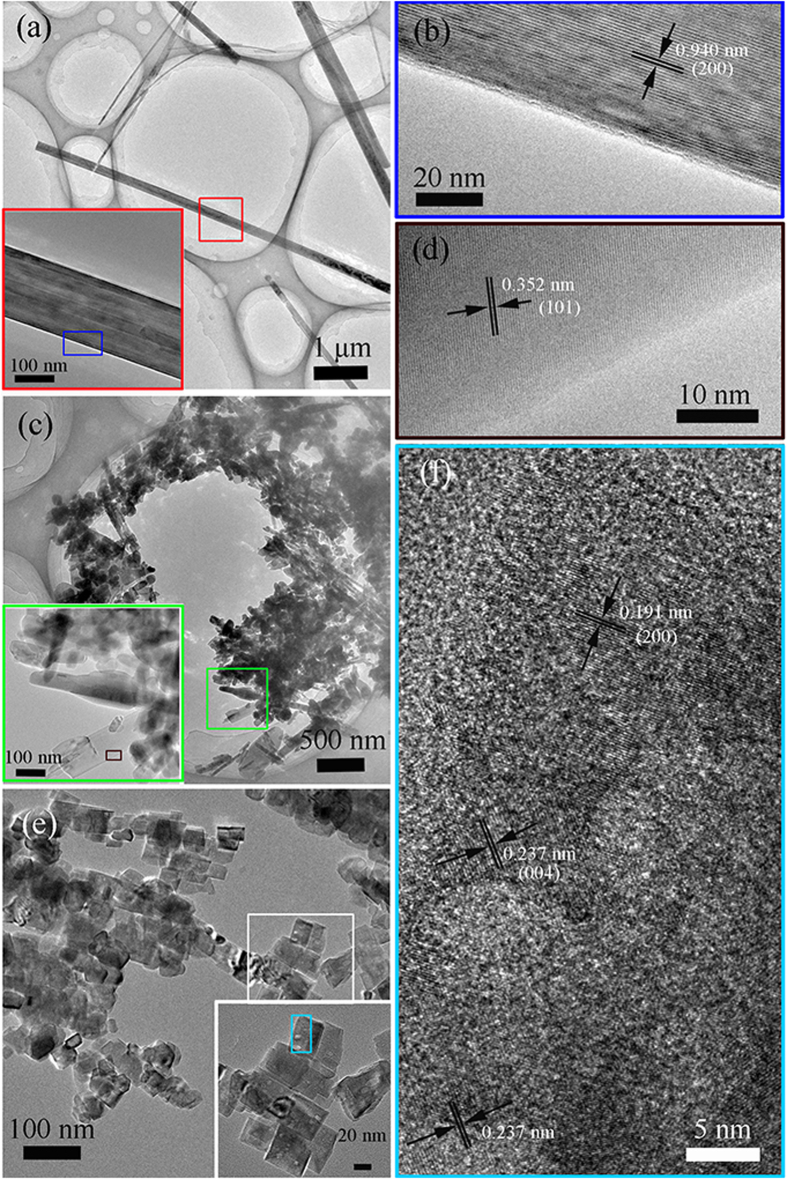
TEM and HRTEM images of the as-prepared samples.(a,b) H-titanate nanowires, (c, d) random shape TiO2 nanostructures obtained in pure water, (e,f) truncated octahedron TiO2 nanoparticles obtained in NH4F solution.